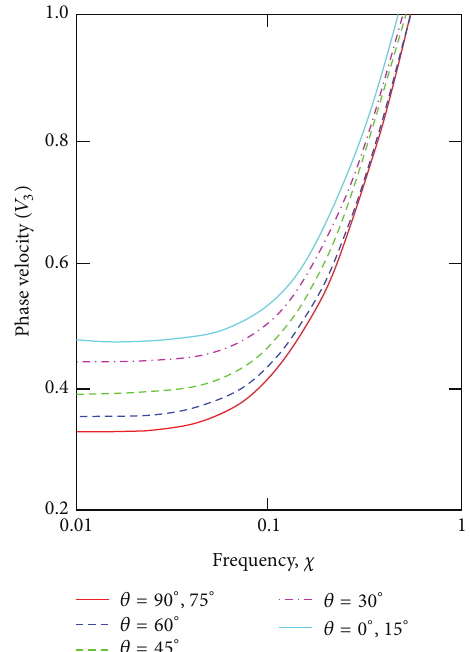
Figure 5: Variation of phase velocity of the N-mode with nondi- mensional frequency in various direction of propagation.